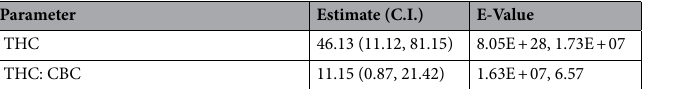
Table 5. E-values of instrumental variable regression models. E-Values from instrumental variable regression models.